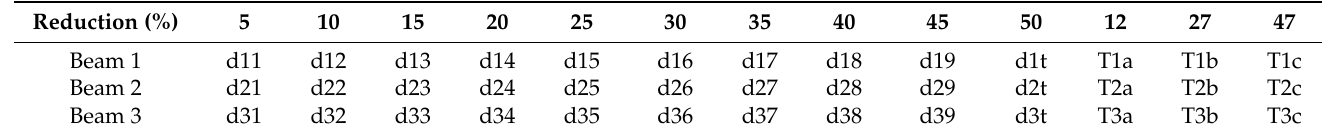
Table 2. Damage situations for sluice hoist beams.